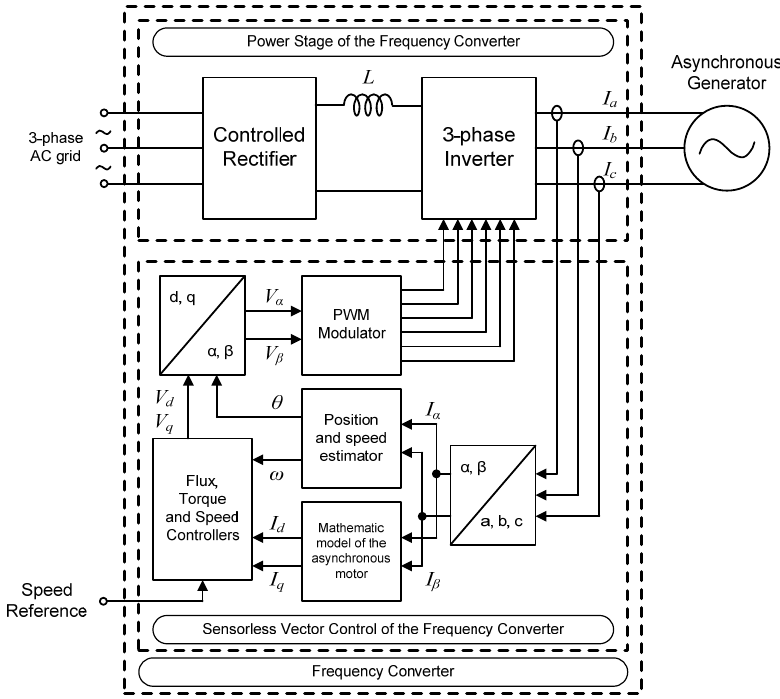
Figure 2. Block diagram representing sensorless vector control in a frequency